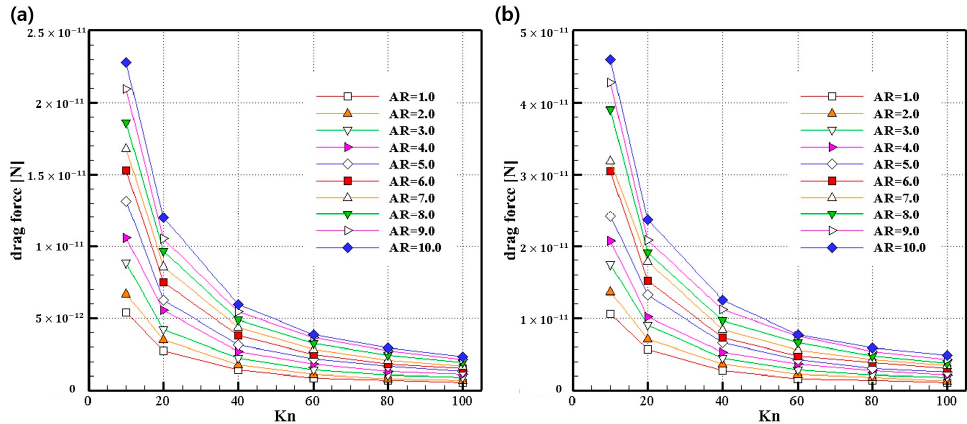
Figure 6. ( a ) Drag force for various aspect ratios ( D x = 50 nm). ( b ) Drag force for various aspect ratios ( D x = 100 nm).